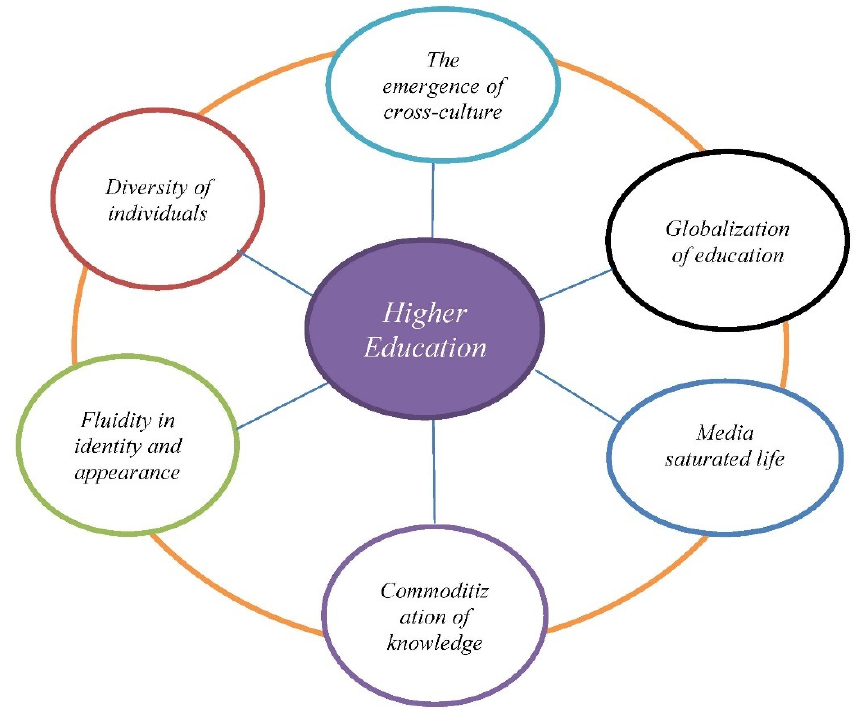
Figure 3. The key characteristic of postmodern education society. Source: Based on Lyotard (1984), Richardson and Jencks (1989), Kahraman (2015), and Authors’ proposal (2022).